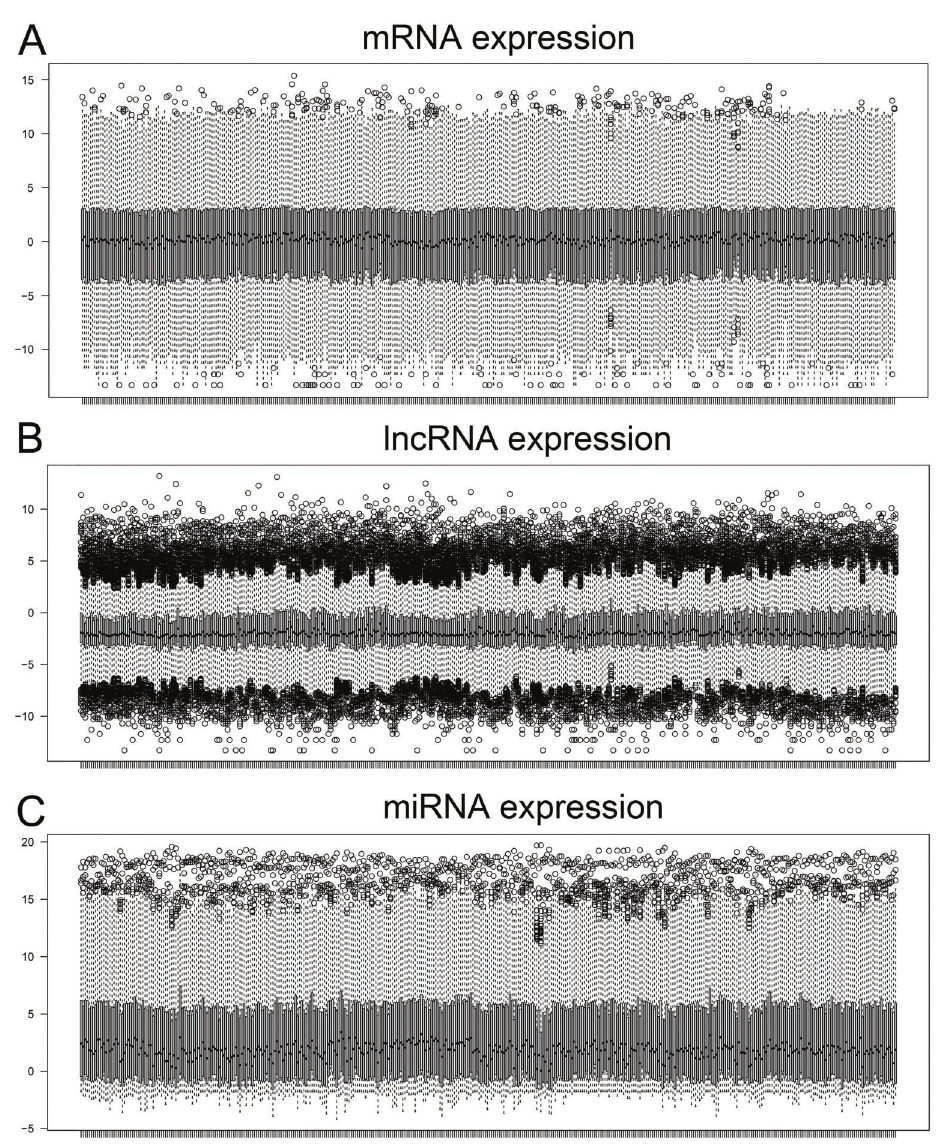
Figure 1. Box plot distribution of TCGA data related to gastric carcinoma samples. A , messenger RNA (mRNA) expression; B , long non- coding RNA (lncRNA) expression; C , microRNA (miRNA) expression. Horizontal axis indicates cancer samples; vertical axis indicates the expression value distribution of the mRNAs, lncRNAs and